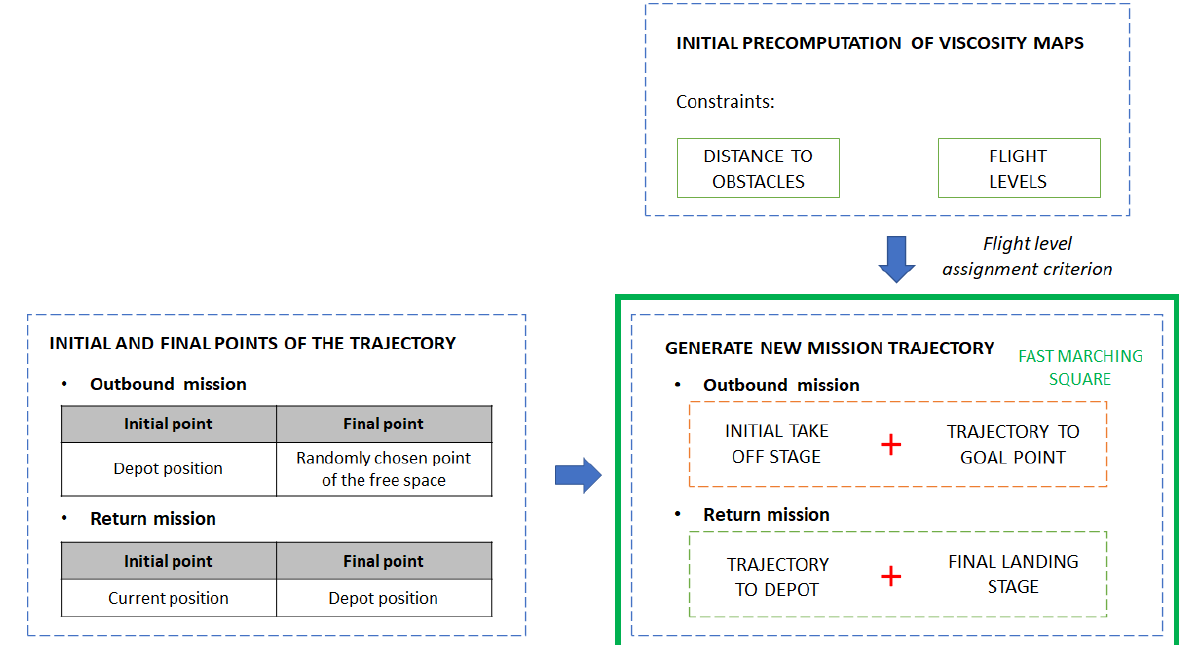
Figure 5. Schematic representation of the path planning stage.